Question: Provide a one-line summary of what is displayed.
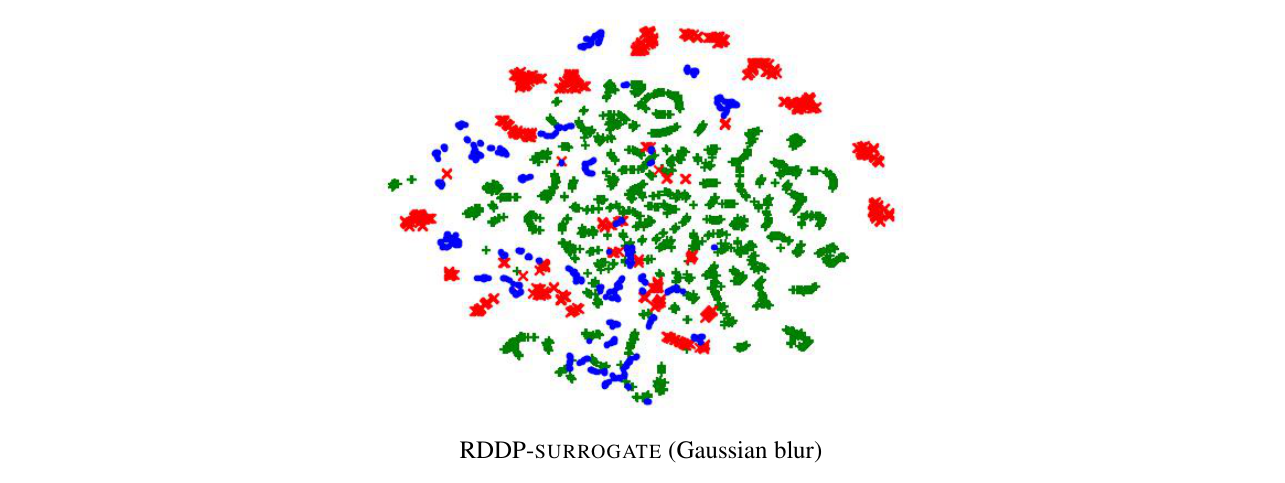
Answer: Frame distributions. We provide t-SNE plots of FAU attribute vectors of sampled testing frames under the RDDP. Green +, blue ◦, red × each represents frame sampled from Dgen, Drecon, Dforged for RDDP-WHITEHAT and Dgen, A ◦Dgen, A ◦Dforged for RDDP-SURROGATE (Resize, JPEG compression, Video compression and Gaussian blur). The mixture of blue ◦and red × being separate from the green + cluster in each plot demonstrates RDDP reducing the distribution shift between genuine and forged examples.